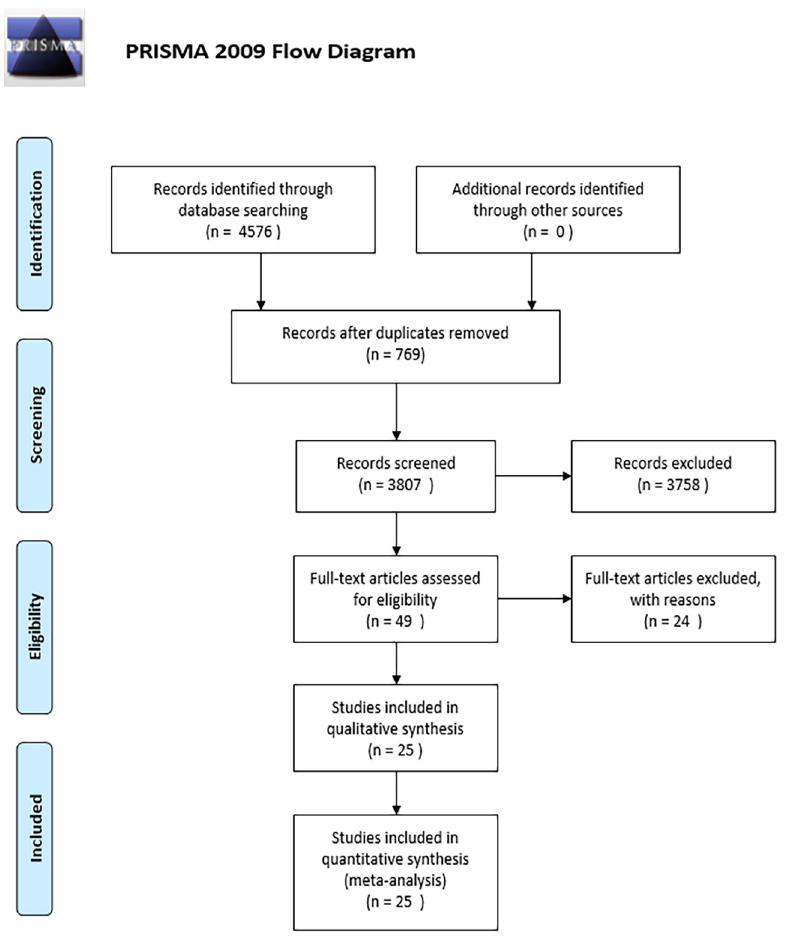
Fig 1. Study selection. From : Moher D, Liberati A, Tetzlaff J, Altman DG, The PRISMA Group (2009). P referred R eporting I terns for S ystematic Reviews and M eta- A nalyses: The PRISMA Statement. PLoS Med 6(7): e1000097. doi:10.1371/journal.pmed1000097 For more information, visit www.prisma-statement.org.